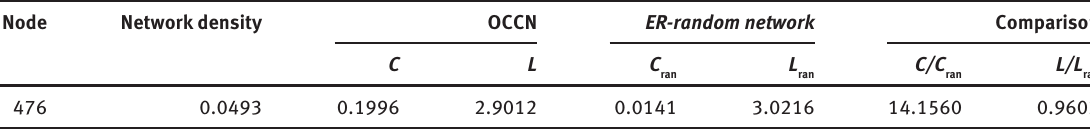
Table 1. Comparison between the OCCN and the ER-Random Network . Node